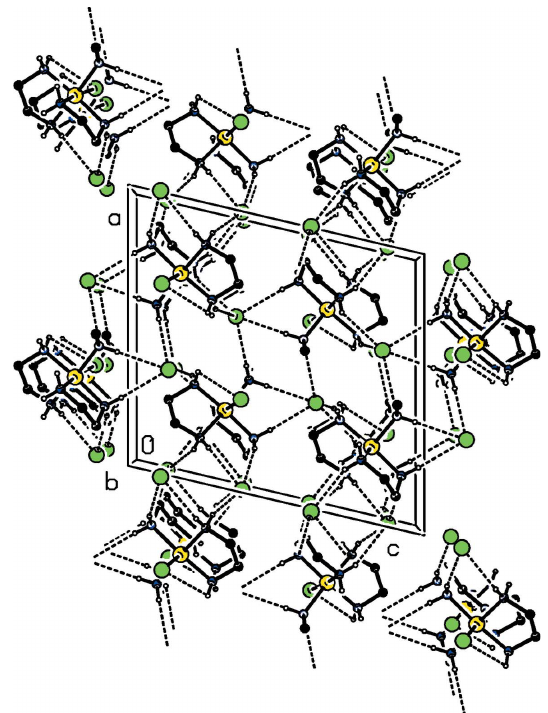
Figure 2 A view along the b axis of the crystal packing of the title compound. The N—H (cid:3)(cid:3)(cid:3) Br hydrogen bonds are shown as dashed lines (Table 1). For clarity, C-bound H atoms have been omitted unless involved in hydrogen bonding.